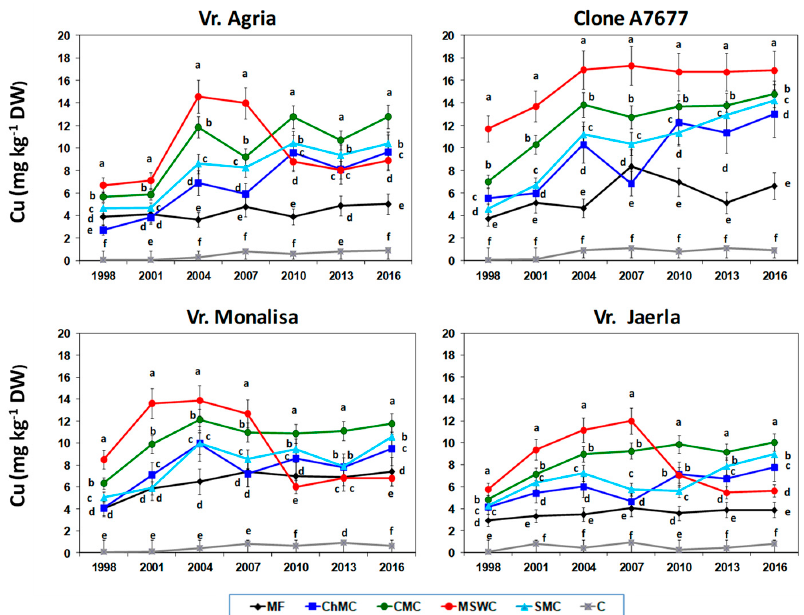
Figure 10. Evolution of copper content (mg kg − 1 DW) in potato tubers of the Agria, Monalisa, Jaerla and clone A7677 varieties (1998–2016) versus the application of compost from different organic amendments. The means with different lowercase letters within each season indicate significant differences between the treatments ( p < 0.001). Bars stands for standard deviations. MF: mineral fertilizer; ChMC: chicken manure compost; CMC: cow manure compost; MSWC: municipal solid waste compost; SMC: sheep manure compost; C: control.